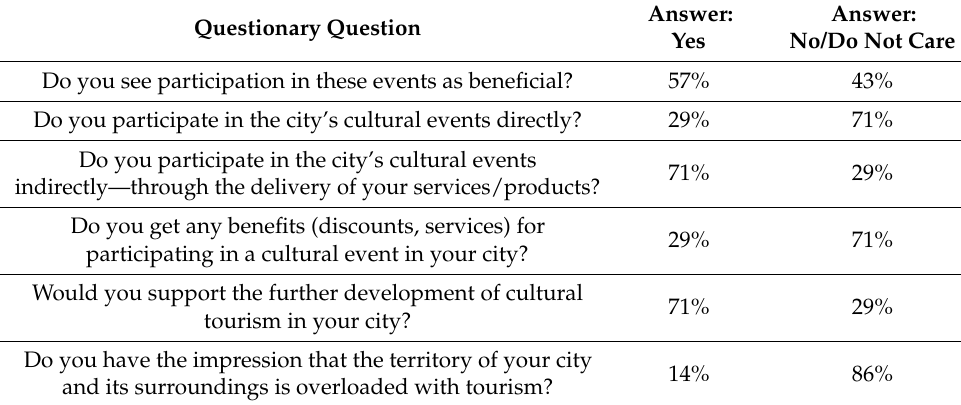
Table 3. Business involvement and support of cultural activity in